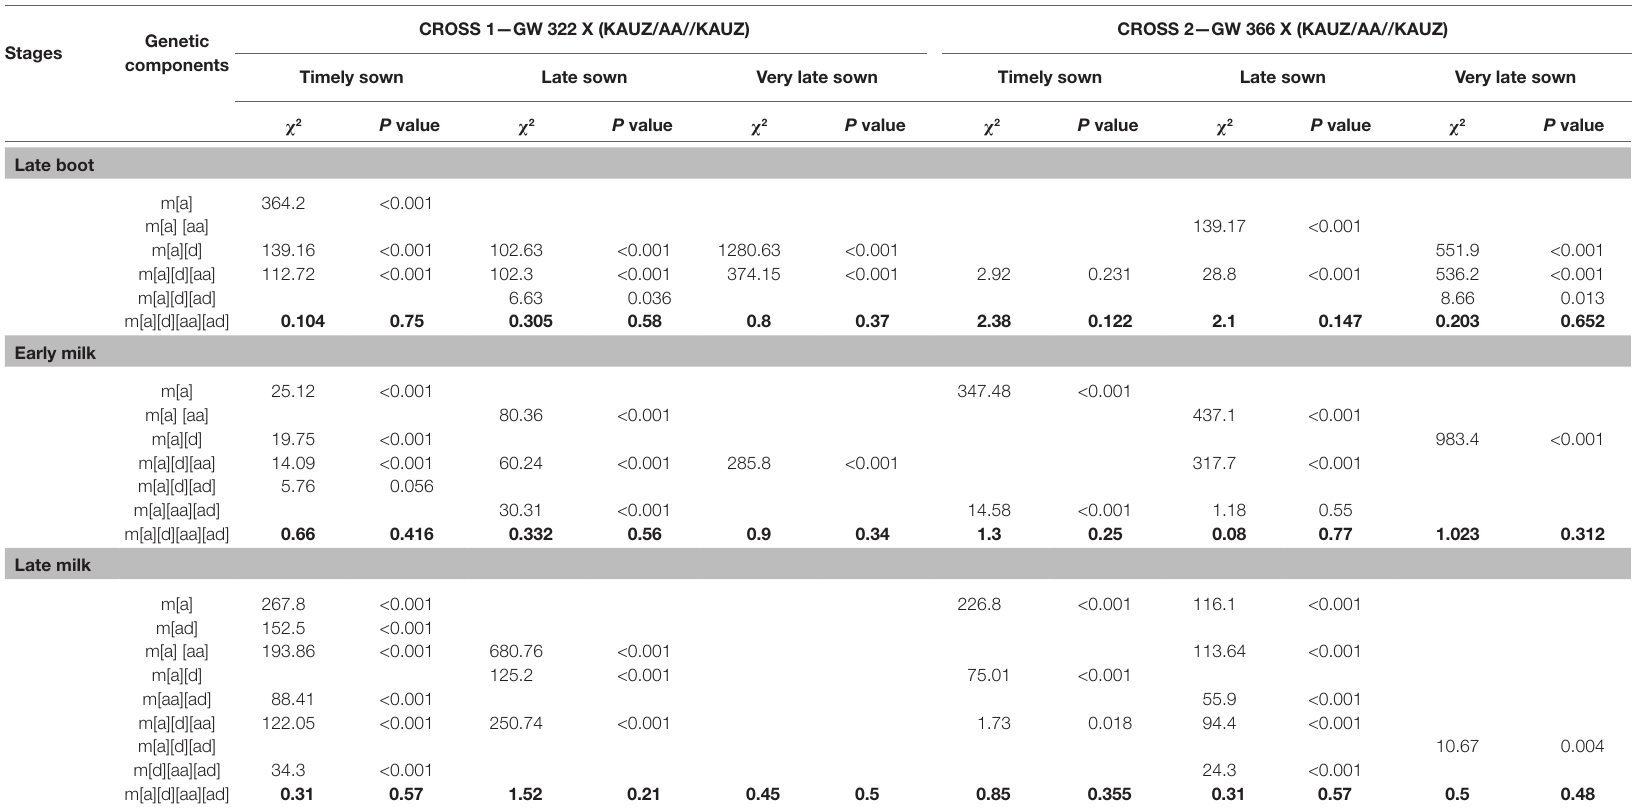
TABLE 4 | Chi-square and probability for goodness-of-fit test of appropriate genetic models for stomatal conductance in two crosses, GW 322 X (KAUZ/AA//KAUZ) and GW 366 X (KAUZ/AA//KAUZ), during three growth stages under timely, late, and very late sown condition. CROSS 1—GW 322 X (KAUZ/AA//KAUZ) CROSS 2—GW 366 X (KAUZ/AA//KAUZ) Genetic Stages components Timely sown Late sown Very late sown Timely sown Late sown Very late